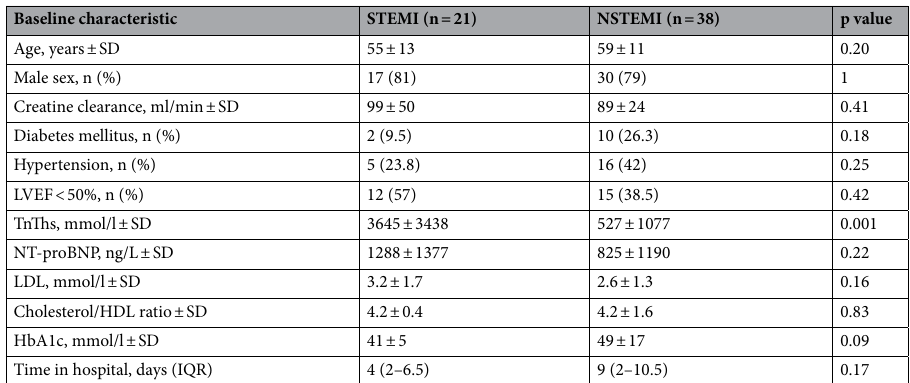
Table 3. Baseline characteristics and biomarkers for the STEMI and NSTEMI populations. SD standard deviation, STEMI ST segment elevation myocardial infarction, NSTEMI non ST segment elevation myocardial infarction, TnThs high-sensitivity troponin T, NT-proBNP N terminal pro brain natriuretic peptide, LDL low density lipoprotein, HDL high density lipoprotein, HbA1c glycated haemoglobin, LVEF left ventricular ejection fraction, IQR interquartile